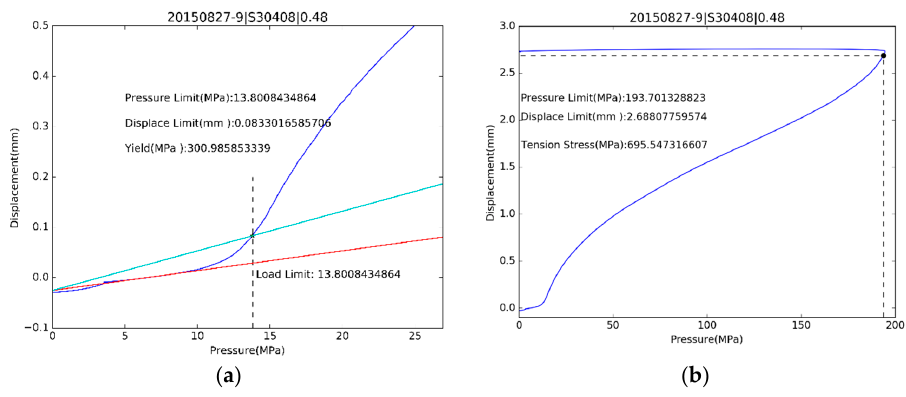
Figure 10. The estimation for ( a ) yield stress and ( b ) ultimate tensile strength of S30408.